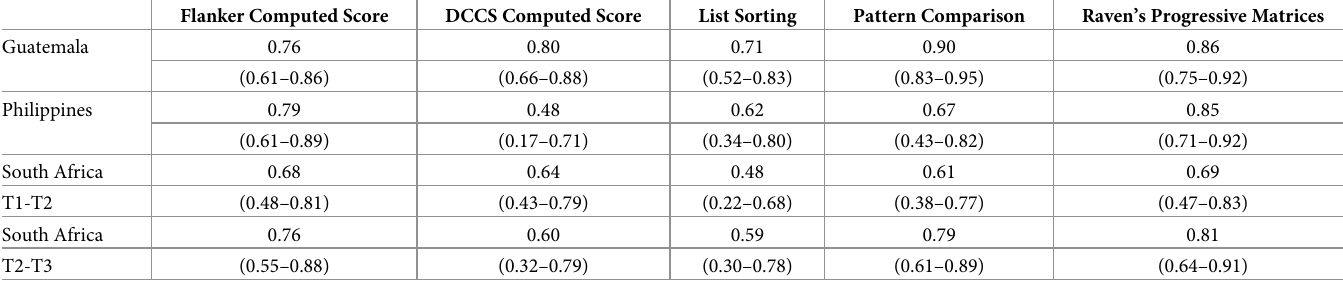
Table 8. Intraclass Correlation Coefficients (ICC) with 95% confidence intervals between time points for each